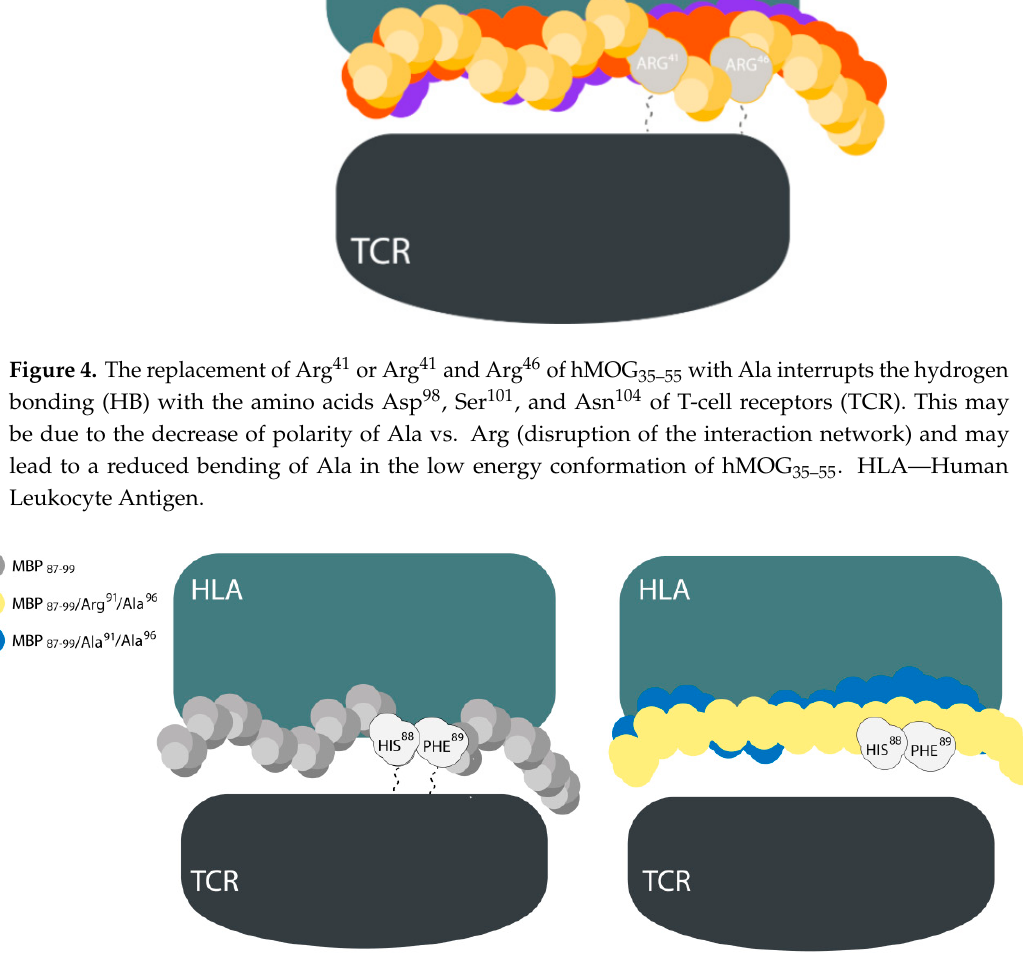
Figure 5. ( left ) His 88 and Phe 89 of hMBP 87–99 (myelin basic protein) interact with the TCR receptor. ( right ) In the two antagonists (Arg 91 , Ala 96 ) MBP 87–99 and (Ala 91,96 ) MBP 87–99 this interaction is lost as the two amino acids are buried in HLA grooves.